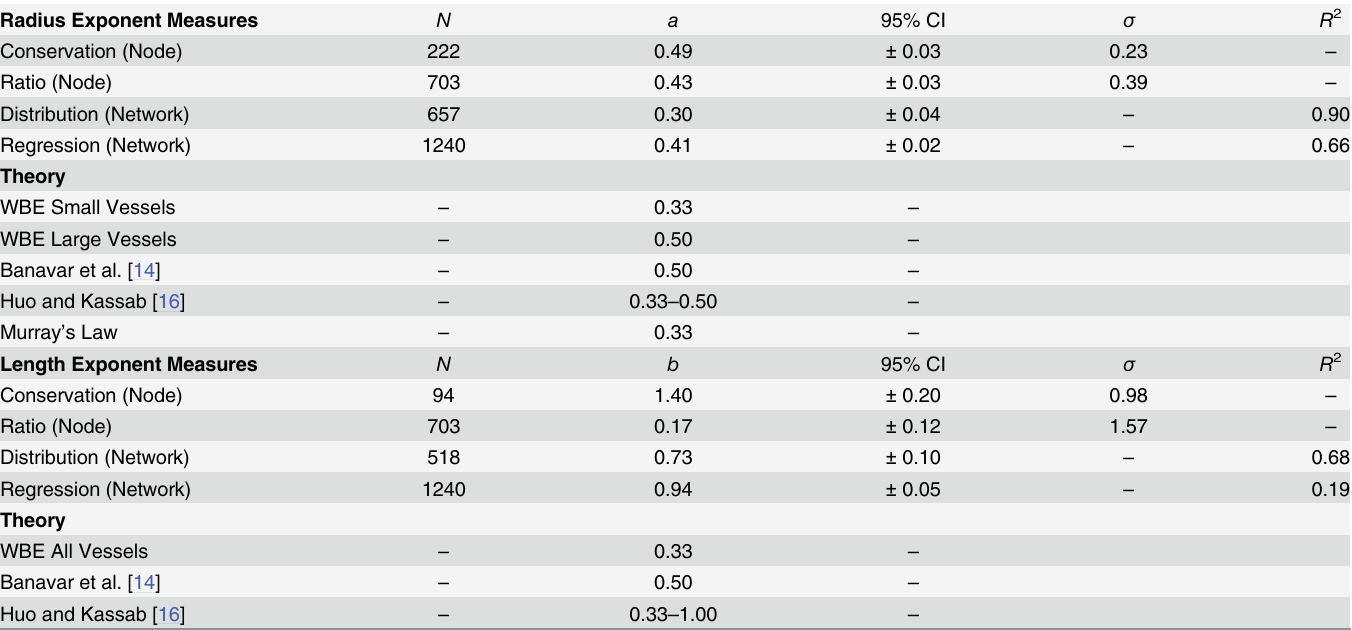
Table 1. Measures and theoretical values of the scaling exponents a and b . N denotes the number of measurements incorporated in the average or slope. The 95% CI indicates the range of confidence on the average or slope. For node-level measures, σ indicates the standard deviation of measurements made for individual junctions or parent-child pairs for conservation- and ratio-based measures respectively. For network-level (regression- and distribution- based) measures, R 2 denotes the correlation in the fit. For distribution-based measures, this correlation is between the natural log of bin size and mean vessel dimension (i.e., radius or length) in the bin. For regression-based measures, this correlation is the correlation between the natural log of dimension and the natural log of the number of downstream endpoints. For conservation-based measures, N counts all junctions of three or more well-segmented vessels (see Software and Algorithm) for which Eqs 1a or 1b had a solution. For ratio-based exponents, N counts all parent-child pairs of vessels in which both the parent and child are well-segmented. For distribution-based exponents, N counts the number of well-segmented vessel segments exceeding the minimum-size threshold described in Data Fitting. For regression-based exponents, N counts all well-segmented vessels. The 95% CIs are derived in a manner appropriate to each method: They are 1.96 times the standard error on the mean for conservation- and ratio-based measures and the confidence interval on the SMA regression slope for regression-based measures. For distribution-based measures, they are the range of the middle 95% of slopes derived from alternative binning as described in Data